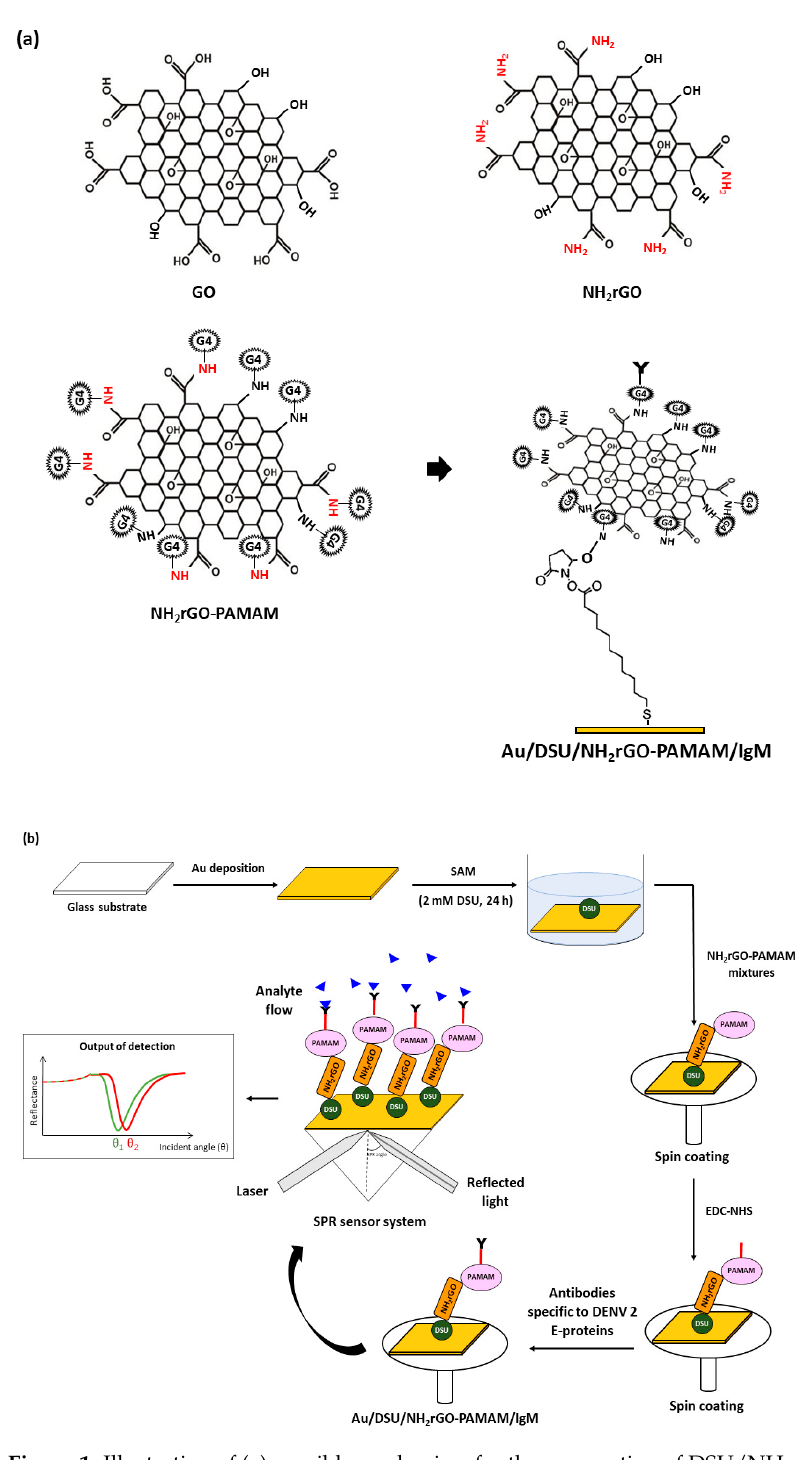
Figure 1. Illustration of ( a ) possible mechanism for the preparation of DSU/NH 2 rGO–PAMAM/IgM and ( b ) sensor film preparation.